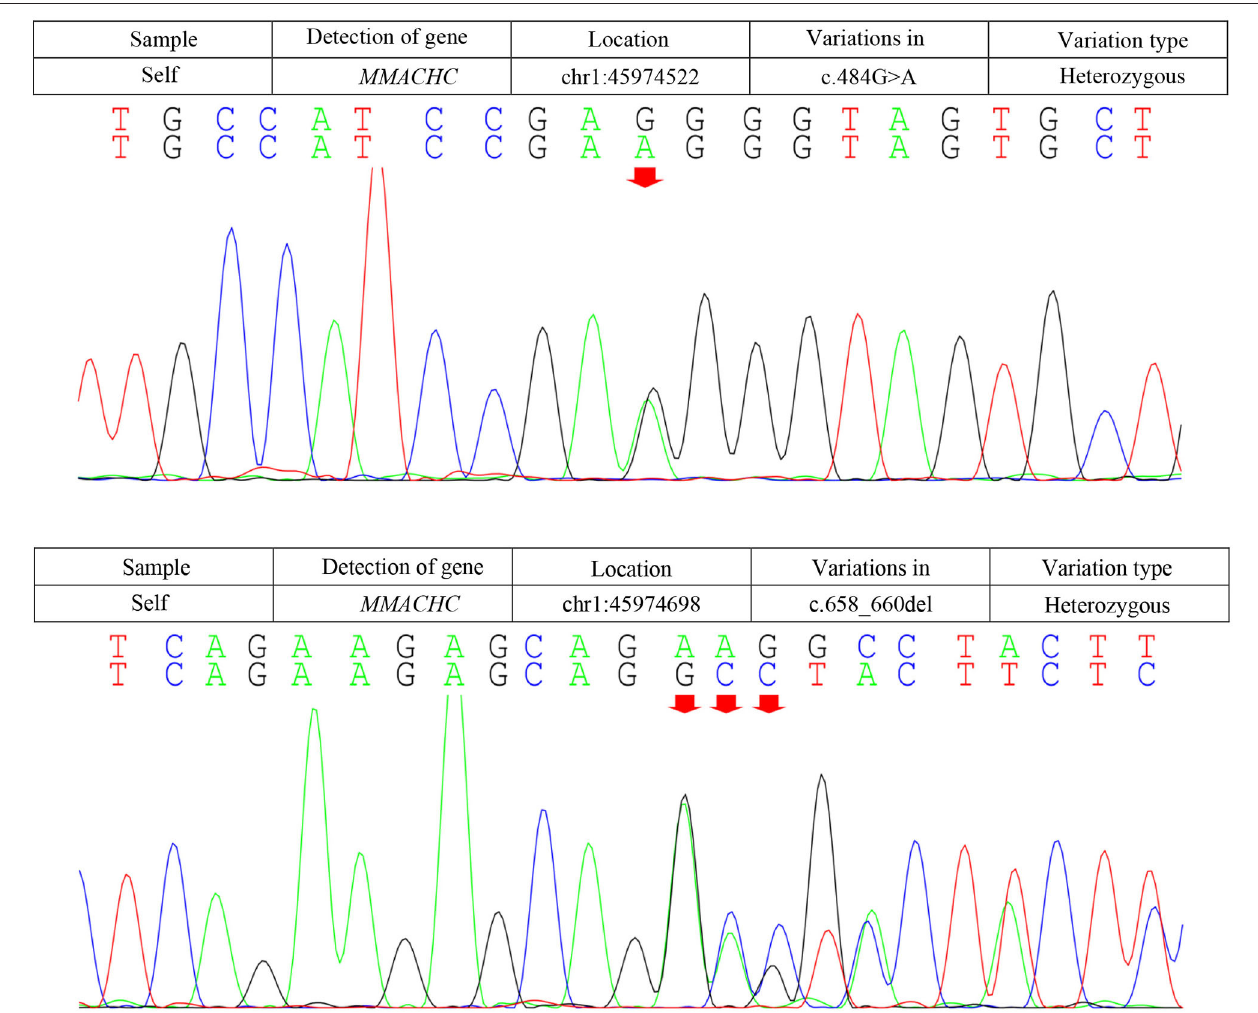
FIGURE 3 | Results of the MMACHC gene test. Gene mutation in c.484G > A and c.658_660del. c.484G > A (red arrows) was observed due to an amino acid change in codon position 162, which is highly suspected to be a new genetic